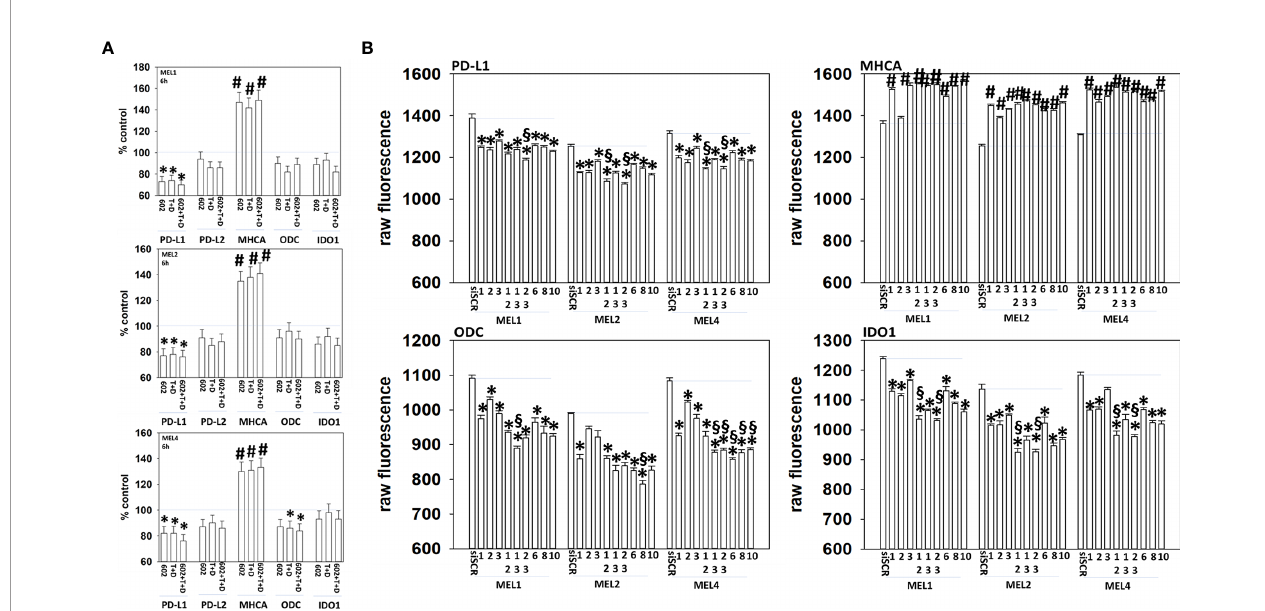
FIGURE 11 | Genetic manipulation of HDAC expression results in reduced expression of PD-L1, ODC and IDO1 and elevated levels of MHCA. (A) Melanoma cells were treated with vehicle control, GZ17-6.02 [curcumin (2 µM) + isovanillin (37.2 µM) + harmine (4.5 µM)], [trametinib (T, 2 µM) + dabrafenib (D, 2 µM)] or the drugs in combination for 6h. Cells were fi xed in place and in-cell immunostaining performed to determine the expression of the indicated proteins and total ERK2 as a loading control. Bar graphs are corrected for the total loading of ERK2. (n = 3 +/-SD) *p < 0.05 less than vehicle control; # p < 0.05 greater than vehicle control. (B) Melanoma cells were transfected with an scrambled siRNA (siSCR) or with siRNA molecules to knock down the expression of HDAC proteins, as presented in the Figure. Twenty- four h later, cells were fi xed in place and in-cell immuno-staining performed to de fi ne the expression of PD-L1, MHCA, ODC, IDO1 and the total expression of ERK2 as a loading control. The values presented in the bar graphs are corrected for total ERK2 levels under each condition. A representative study in triplicate from three independent experiments. (+/-SD) # p < 0.05 greater than siSCR value; *p < 0.05 less than siSCR value. $ Less than individual knock down of an HDAC protein.